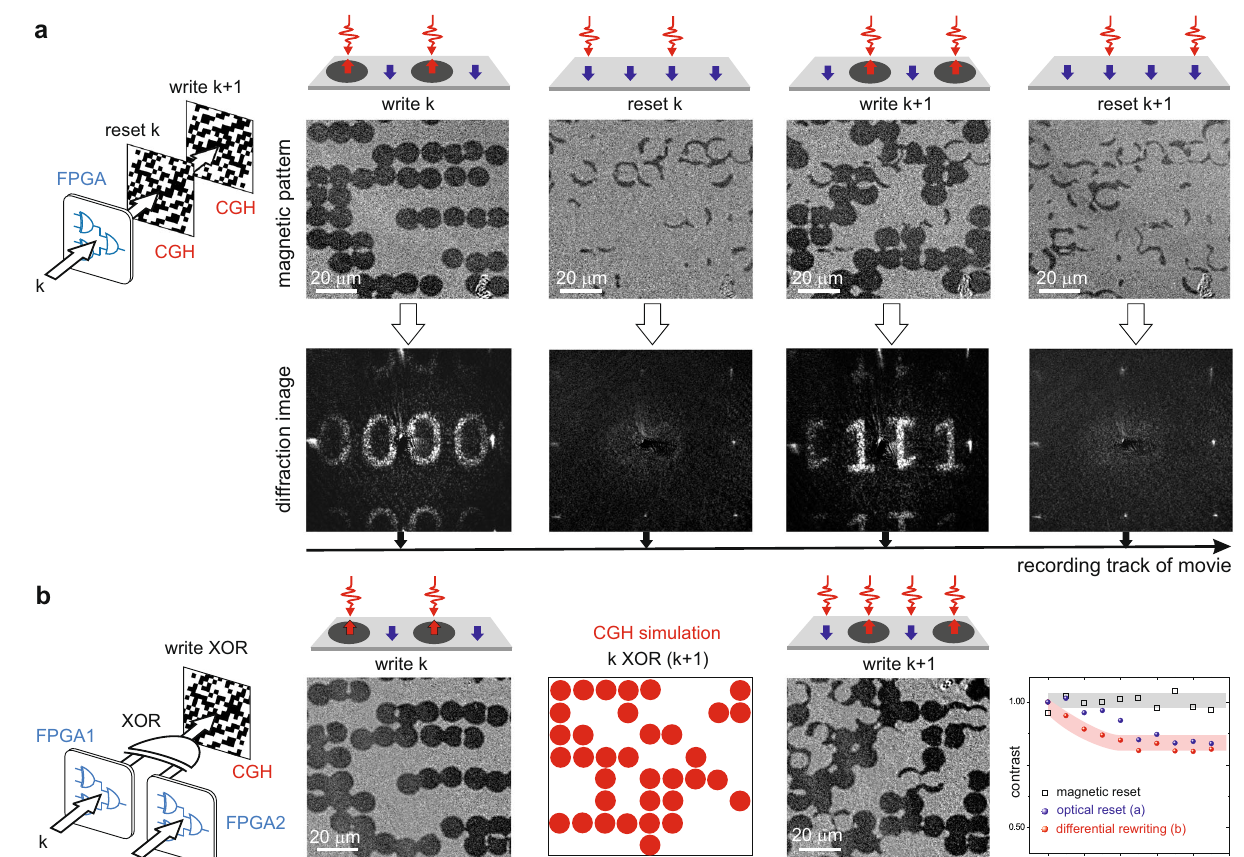
Fig. 2 | Dynamic opto-magnetic rewriting of subsequent holographic frames. a Optical reset mode comprising subsequent writing of k and k +1 holographic patterns using toggle regime of AOS. From left to right: writing of pattern